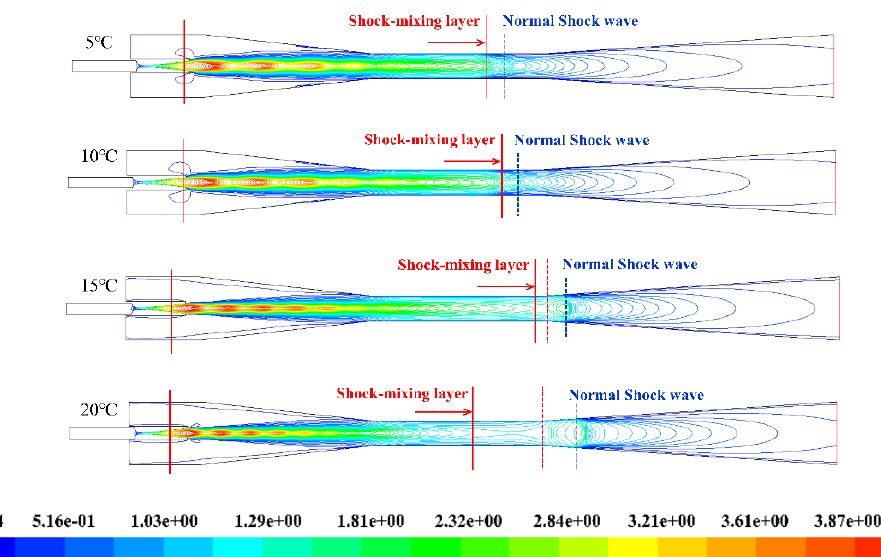
Figure 12. The contours of Mach number for various secondary fluid temperature.